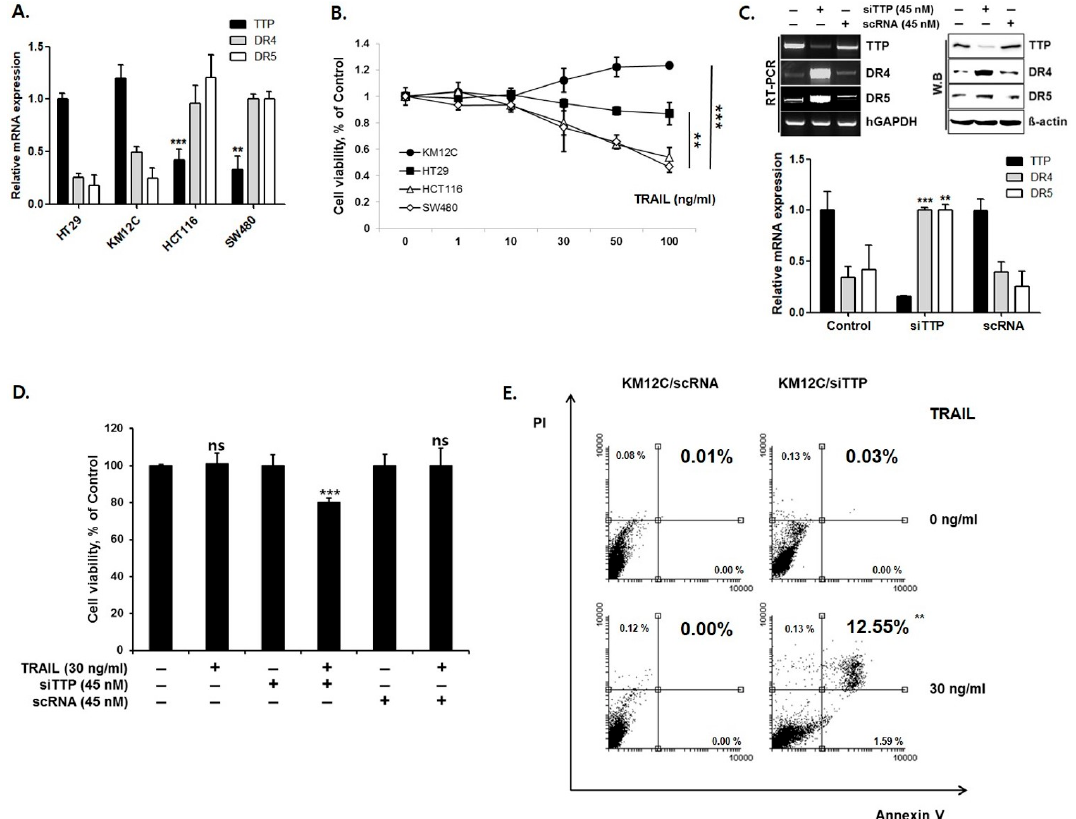
Figure 1. TTP inhibits DR4/5 expression in human colon cancer cells. ( A ) Levels of TTP, DR4, and DR5 expression in four human colon cancer cell lines were determined by quantitative real-time PCR (qRT-PCR). ( B ) MTS assay; viability of KM12C and HT29 cells with TRAIL treatment was higher than that of HCT116 and SW480 cells. KM12C cells with high TTP expression and low DR4/5 expression, and SW480 cells with low TTP expression and high DR4/5 expression were selected for further studies. ( C ) Expression of TTP and DR4/5 in TTP siRNA-treated or control siRNA (scRNA)-treated KM12C cells by qRT-PCR and Western blot analysis. ( D ) MTS assay; siTTP sensitizes KN12C to TRAIL. ( E )